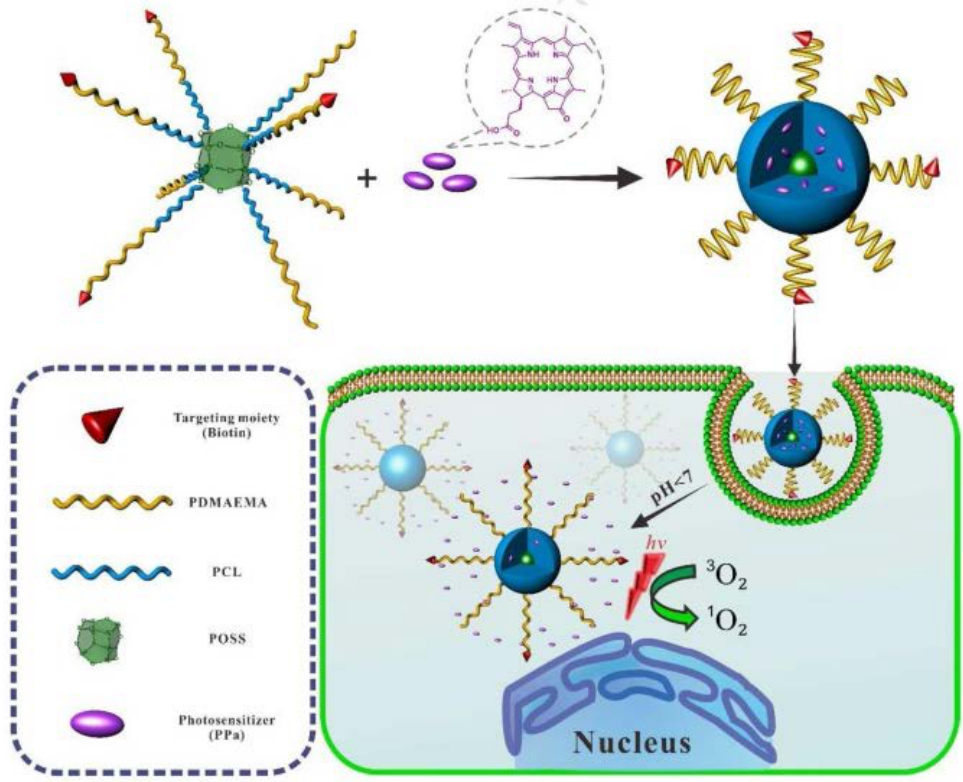
Figure 15. Construction of unimolecular micelles and the process of photodynamic therapy (PDT). Reprinted with permission from [128]. Copyright (2017) Elsevier.